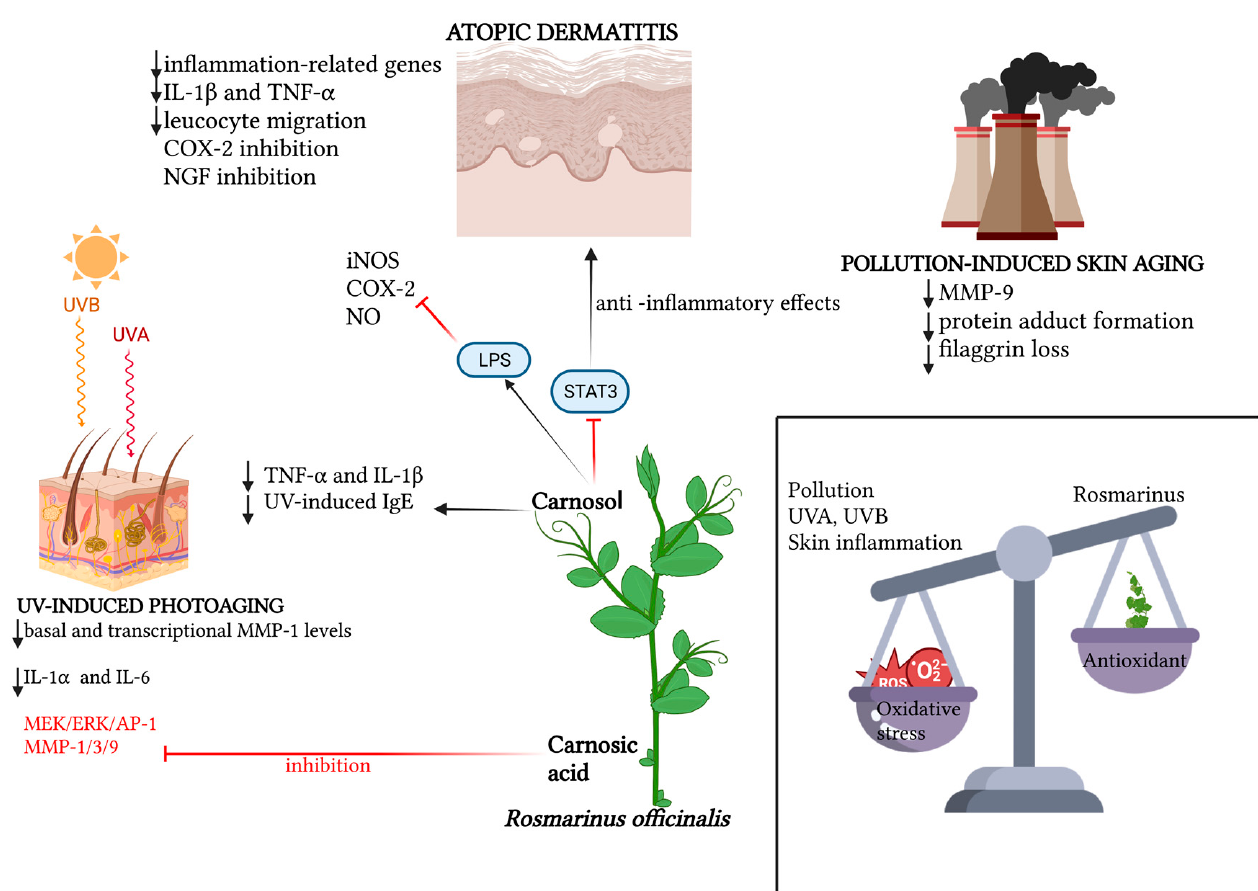
Figure 1. Schematic representation of the relevant molecular patterns involved in the promising antioxidant effects of Rosmarinus officinalis and its main bioactive compounds on three dermatological conditions: atopic dermatitis, UV-induced photoaging and pollution-induced skin aging. In atopic dermatitis, beyond the synergic action of carnosol and carnosic acid in downregulating inflammation-related genes, and therefore pro-inflammatory cytokines, leucocyte migration and NGF inhibition promotion, the specific action of carnosol on the STAT3 pathway is emphasized, for which the LPS-induced phosphorylation lock results in anti-inflammatory effects, together with carnosol’s direct inhibition of iNOS, NO and COX-2 activation. In UV-induced photoaging, the action of Rosmarinus officinalis in downregulating basal and transcriptional levels of MMP-1, as well as the inflammatory cytokines IL-6 and IL-1 α , is highlighted. Also portrayed is the specific action of carnosol in downregulating TNF- α , IL-1 β and serum levels of UV-induced IgE, and the inhibitory action of rosmarinic acid both on the MEK/ERK/AP-1 pathway and on MMP-1, MMP-3 and MMP-9. In pollution-induced skin aging, the downregulatory action of the two main phenolic diterpenes of Rosmarinus officinalis is mainly demonstrated on MMP-9, protein adduct formation and the loss of filaggrin. Created with BioRender.com.